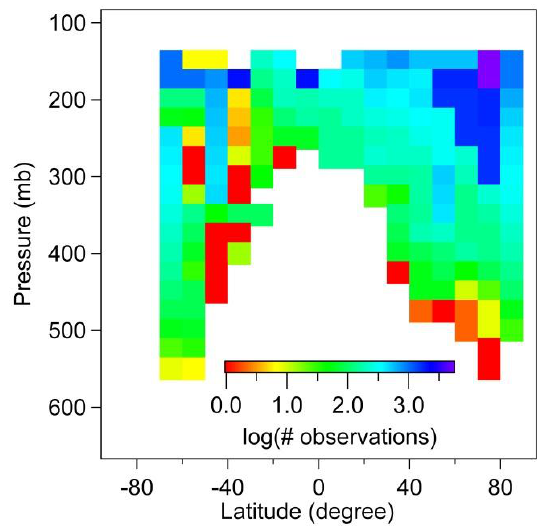
Fig. 3. Distribution of the number of observations at T ≤− 40 ◦ C in the latitudinal and vertical view for the START08 and HIPPO campaigns. The color code shows the number of observations in each 10 ◦ × 25mb bin in the log scale.